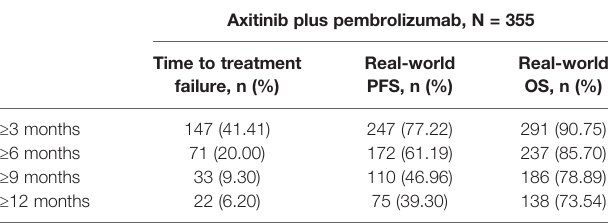
TABLE 3 | Patients experiencing clinical events during follow-up at speci fi ed landmark timepoints.